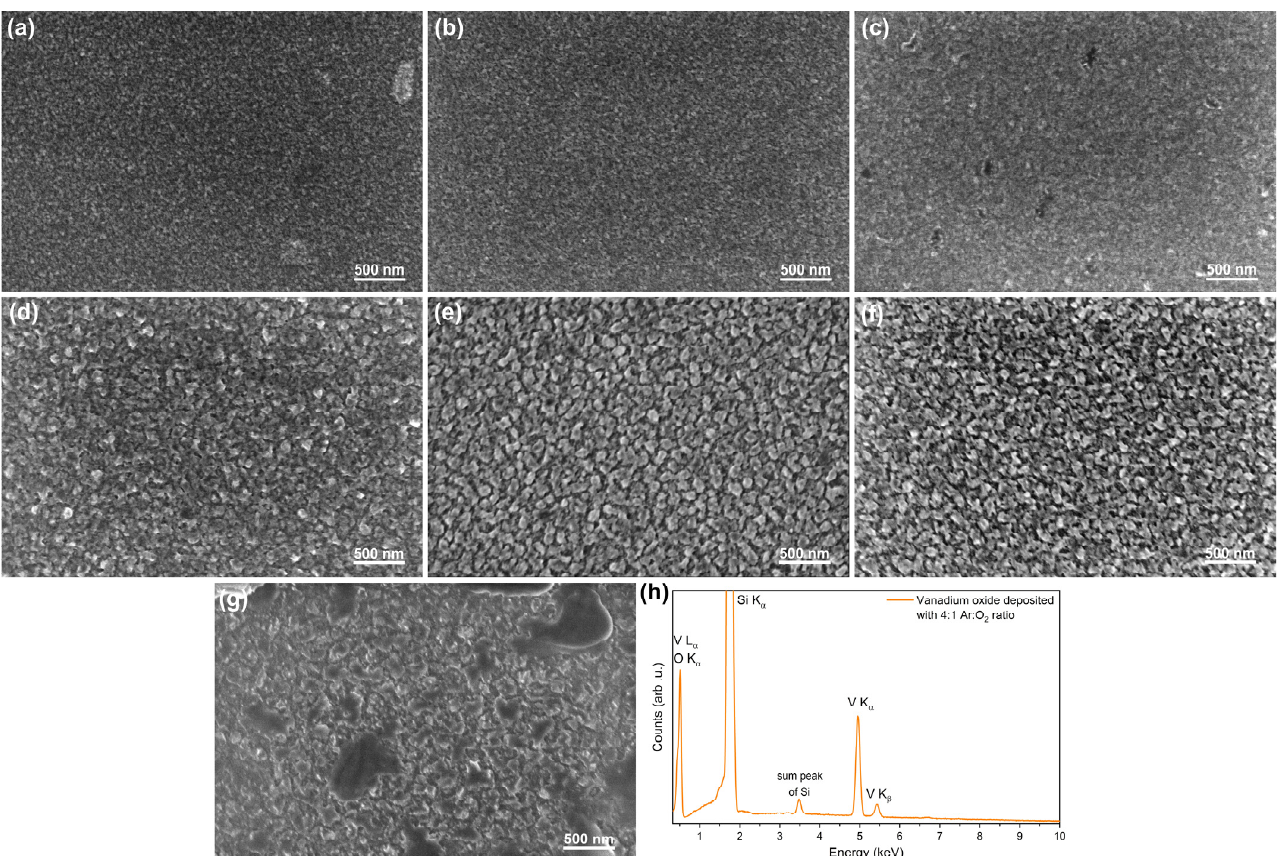
Figure 3. SEM images of the surface morphology of vanadium oxide thin films deposited with various Ar:O 2 gas ratios: ( a ) 2:1, ( b ) 3:1, ( c ) 4:1, ( d ) 5:1, ( e ) 6:1, ( f ) 7:1, ( g ) 8:1 and ( h ) an EDS spectrum of a thin film deposited with Ar:O 2 ratio of 4:1.